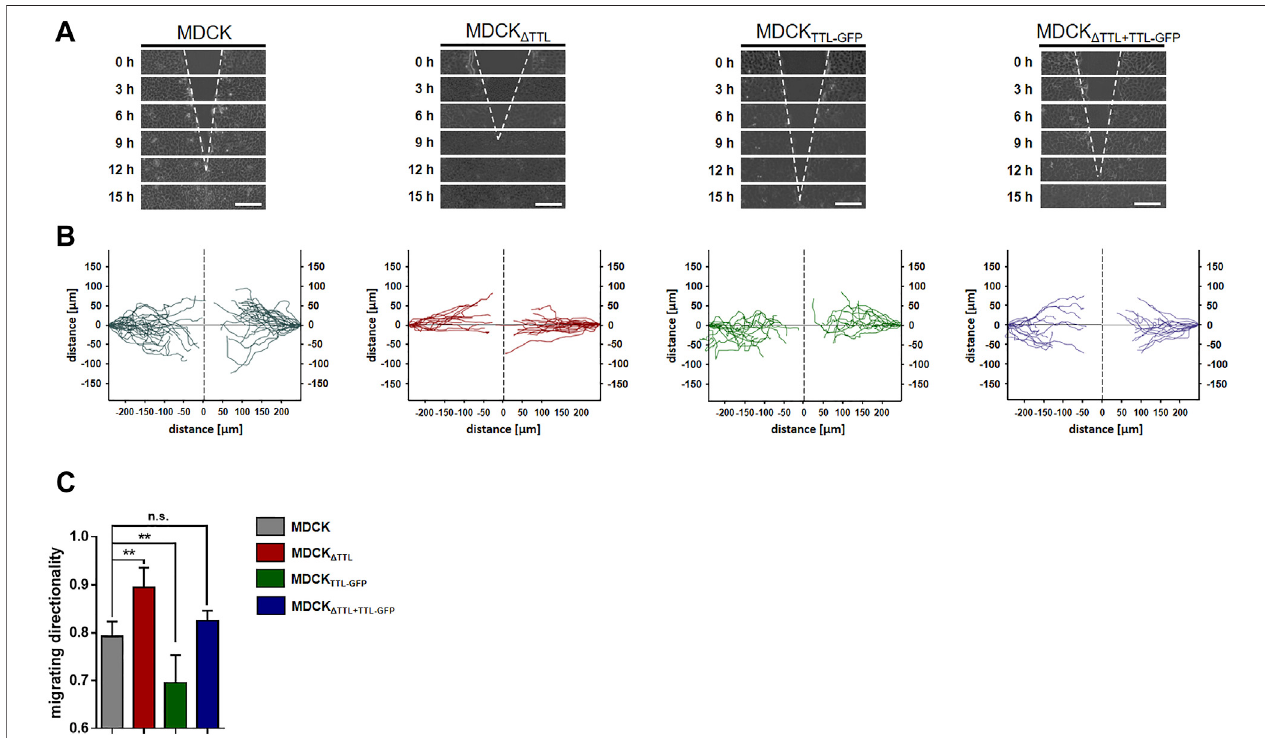
FIGURE 2 | Directionality of cell migration following TTL-modulation. (A) Con fl uent monolayers of MDCK cells were scratch wounded to monitor directional migration. Cells were recorded at 0, 3, 6, 9, 12, and 15 h post-scratching. White dotted lines indicate the wound borders progress over time. Scale bars: 100 µm. (B) Single cell migration was recorded and visualized by Tracking Tool ™ PRO (Gradientech). One line corresponds to one single cell track (C) Cell migration directionality was calculated by Tracking Tool ™ PRO. Mean ± s.d., n = 4 independent experiments per cell line were performed. Statistical signi fi cance was tested using one- way ANOVA with Dunnet ’ s comparison (n.s., not signi fi cant; ** p < 0.01).